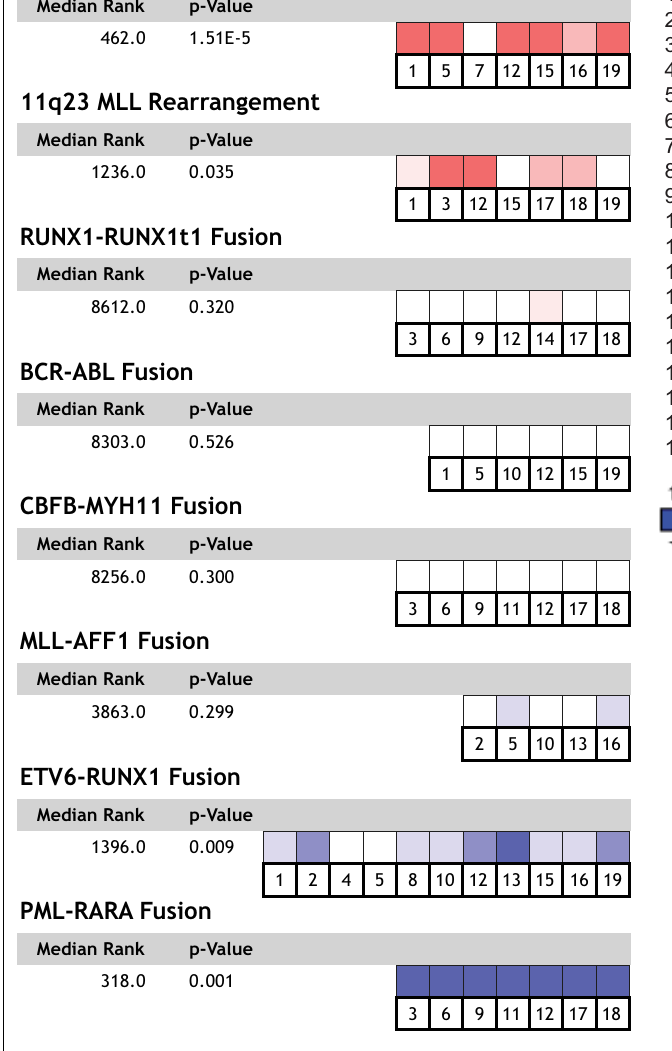
studies with such data.The heatmaps represent the relative expression in patients with the indicated fusions compared to those without, with red indicating over-expression in patients bearing the fusion and blue under-expression. Median ranks and p -values consider all indicated studies